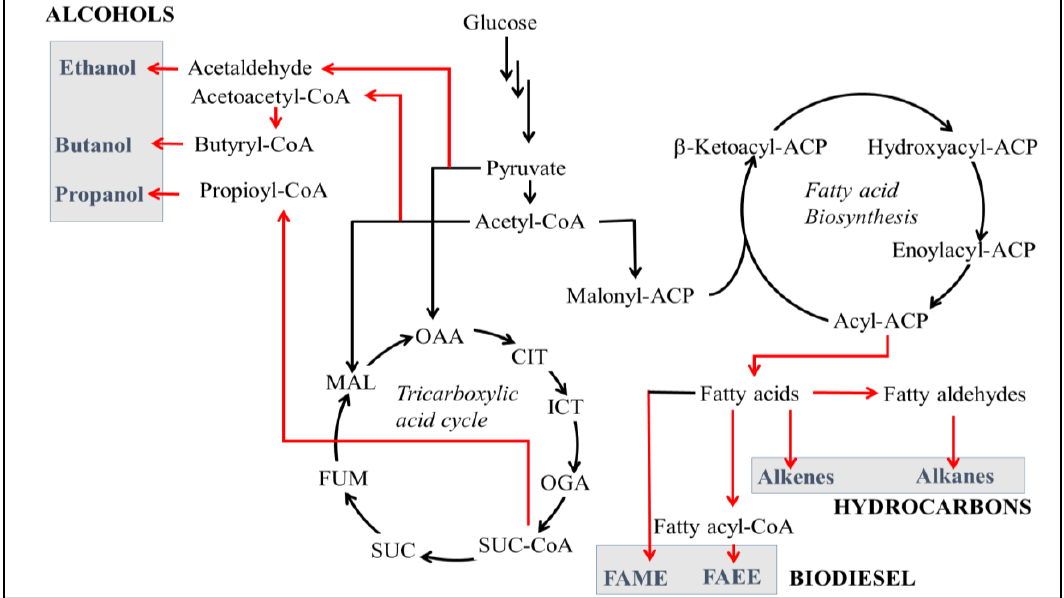
Figure 1. Metabolic pathways of short- and medium-chain alcohols and hydrocarbon production in an engineered bacterial cell. Glucose is metabolized to acetyl-CoA, a precursor of the tricarboxylic acid (TCA) cycle and fatty acid biosynthesis pathways. Short-chain alcohols (ethanol, propanol, butanol) are produced from acetyl-CoA and TCA. Fatty alcohols, fatty acid ethyl esters and n -alkanes are produced by utilizing fatty acyl-ACPs of the fatty acid machinery. The native pathways are shown in black, while heterologous pathways are shown in red. CoA: Coenzyme A; ACP: Acyl Carrier Protein; OAA: Oxalo Acetic Acid; CIT: Citrate; ICT: Iso Citrate; OGA: Oxo Glutaric Acid; SUC: Succinic Acid; FUM: Fumaric Acid; MAL: Malic Acid; FAME: Fatty Acid Methyl Ester; FAEE: Fatty Acid Ethyl Ester.